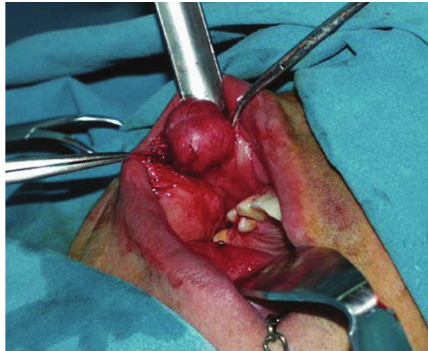
Figure 4: Spindle-shaped cells in a storiform pattern (H&E stain, ×